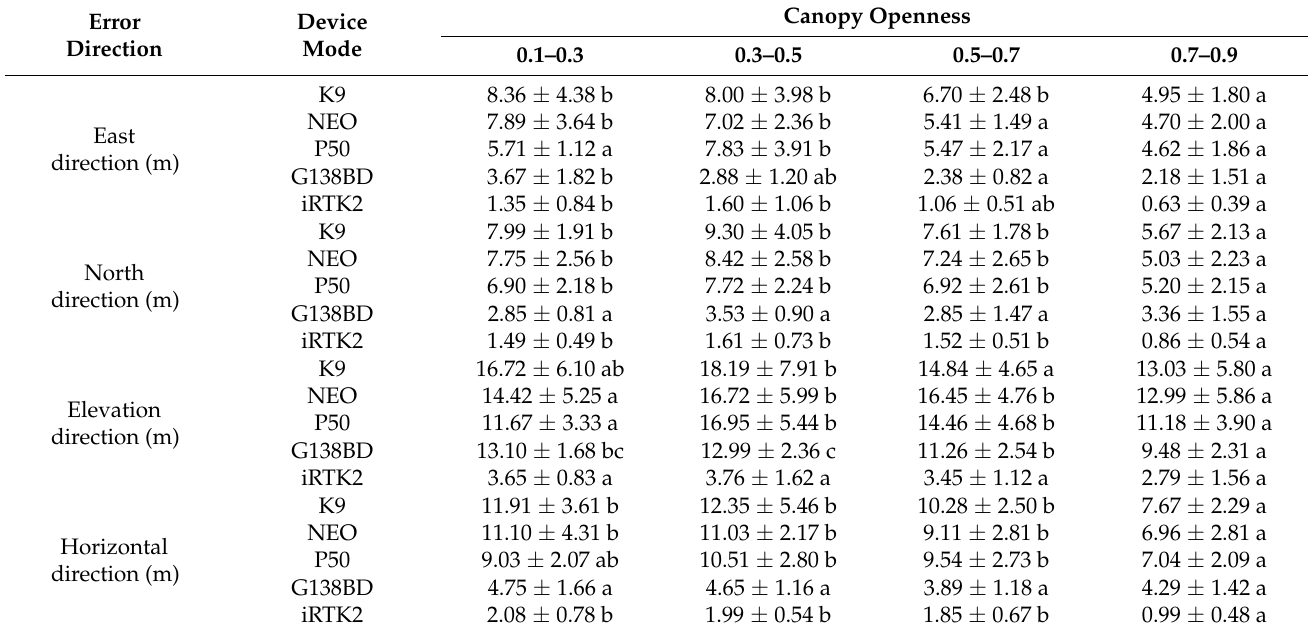
Table 5. Positioning accuracy of each device in single-point positioning (SPP)